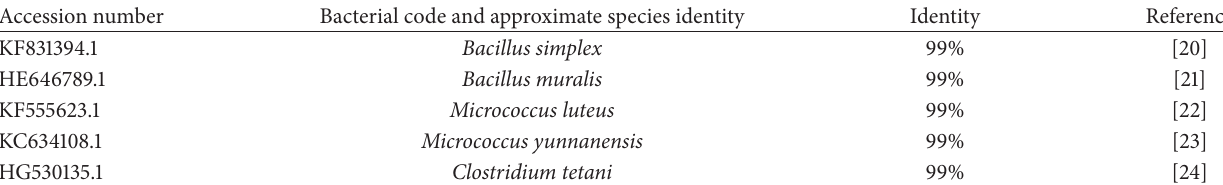
Table 2: Types of the bacteria identified.